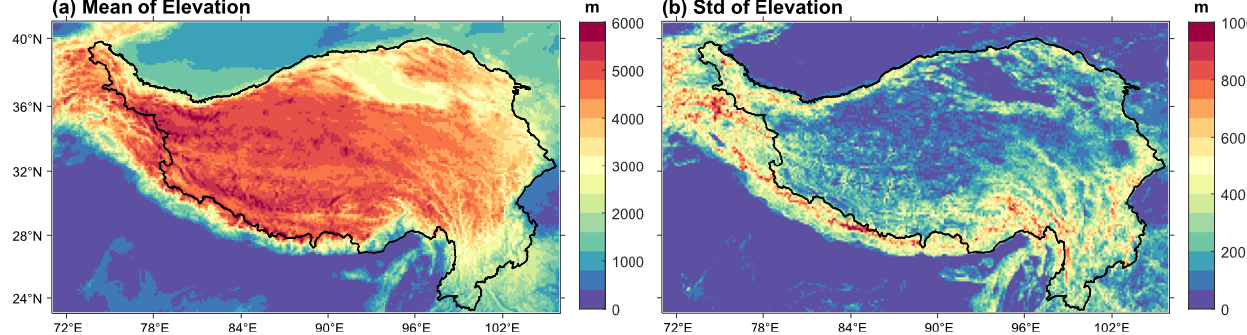
Figure 2. Geographical distributions of the (a) mean and (b) standard deviations of elevation derived from 90m DEM at 0.125 ◦ × 0.125 ◦ spatial resolution over the TP. The black line represents the contour line of